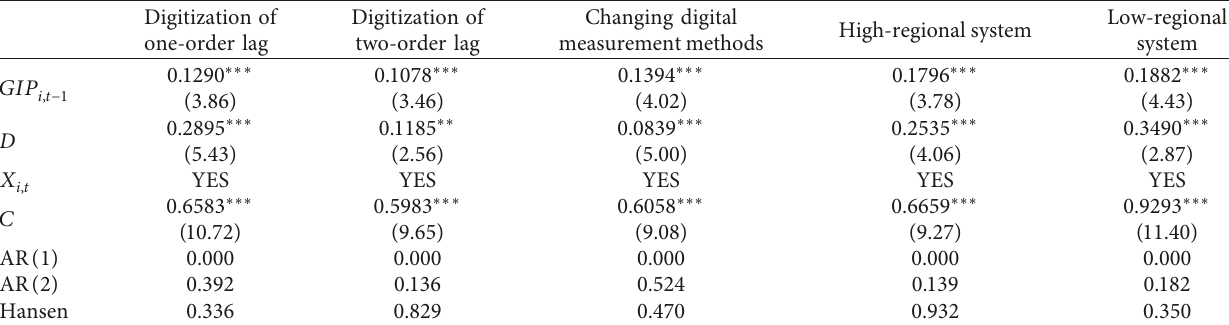
Table 5: Robustness test results of digitalization on green innovation